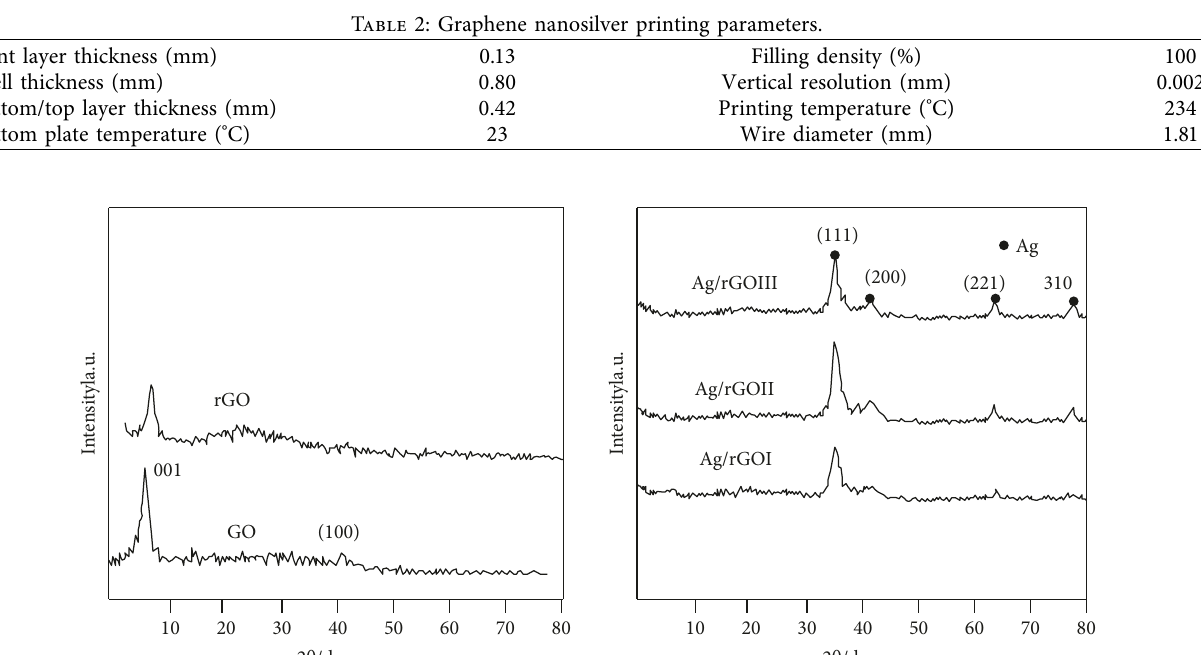
Figure 7: XRD patterns of GO, rGO, and Ag/rGO synthesized with different Ag concentrations.